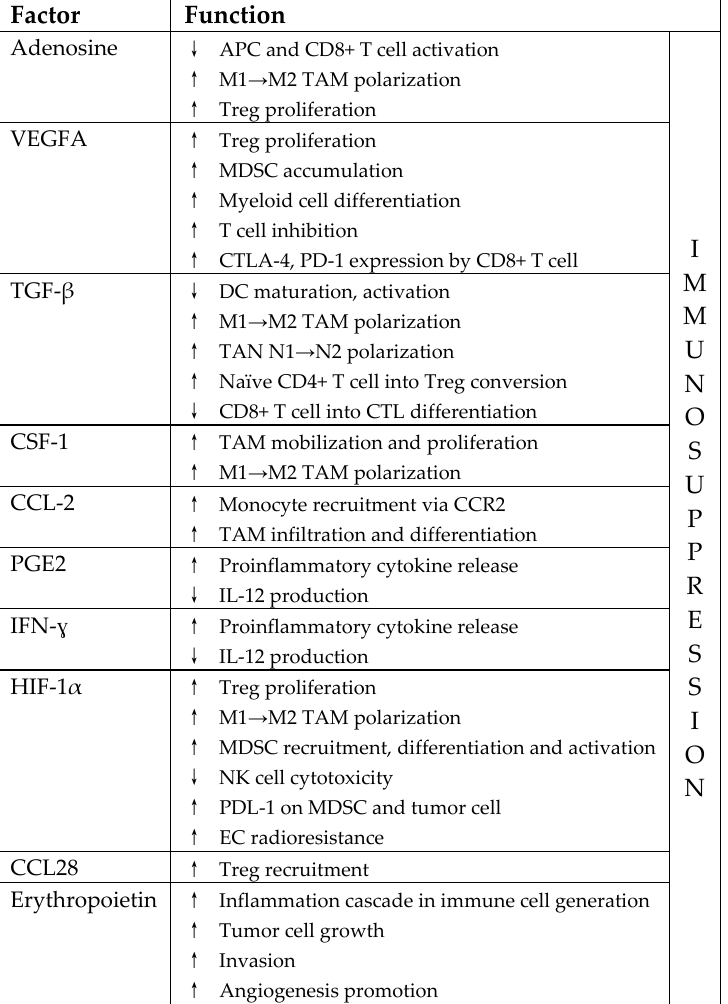
Table 1. Factors activated in the TME in respose to RT that contribute to tumor radioresistance. VEGFA, vascular endothelial growth factor A; TGF- β , transforming growth factor- β ; CSF-1, macrophage-colony stimulating factor; CCL2, C-C motif chemokine ligand 2; PGE2, prostaglandin E2; IFN- γ , interferon- γ ; HIF-1 α , hypoxia-inducible factor 1 α ; CCL28, C-C motif chemokine ligand 28; APC, antigen presenting cells; CTLA-4, cytotoxic T-lymphocyte-associated protein 4; PD-1, programmed death 1; TAN, tumor-associated neutrophil; CTL, cytotoxic T lymphocyte; CCR2, C-C chemokine receptor type 2; PDL-1, programmed death ligand